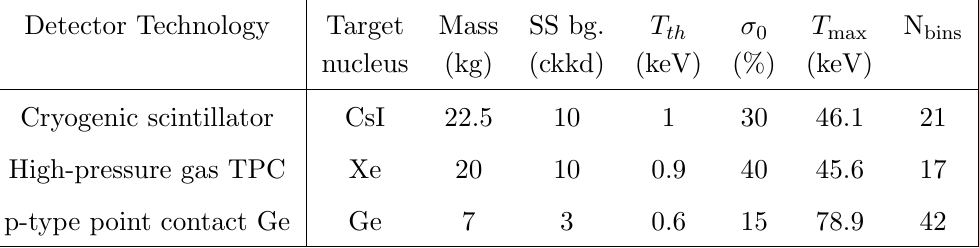
Table 3 . Summary of detector properties and background rates used in our sensitivity calculations. From left to right, the di(cid:11)erent columns indicate the target nucleus, total detector mass, steady-state (SS) background rates, nuclear recoil detection threshold in keV, energy resolution at threshold, maximum recoil energy considered, and the total number of bins used in the simulation (see text for details). Backgrounds rates are listed in counts per keV, kg and day (ckkd), before applying the 4 (cid:2) 10 (cid:0) 2 reduction due to the ESS duty factor. We conservatively adopt a (cid:13)at SS